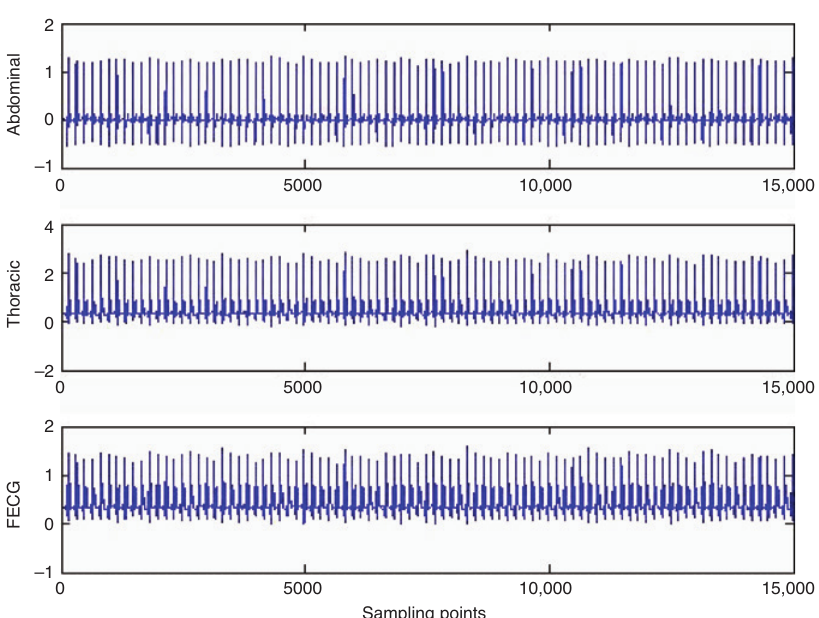
Figure 9: fECG Extraction for Sample Input